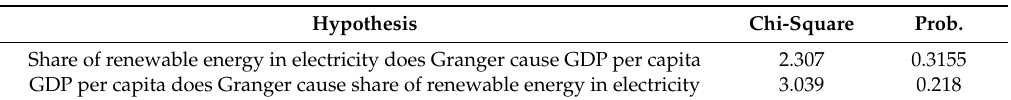
Table 2. Granger causality test to check the relationship between the share of renewable energy in final consumption in the EU-28 countries and GDP per capita (2007–2017).